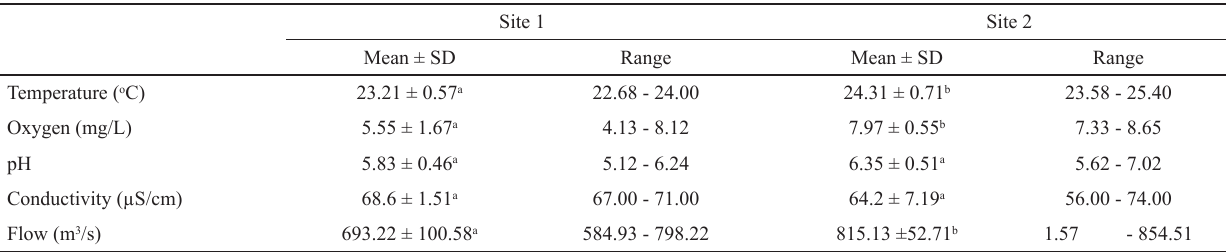
Table 3. Abiotic parameters of the water in two sites of the rio São Francisco, downstream from the Três Marias Dam, between July 2011 and June 2012. Site 1: Immediately downstream from the Três Marias Dam; Site 2: in the confluence with the rio Abaeté. Data are expressed as mean ± standard deviation (SD); different superscripts with means indicate differences between river sites (P <